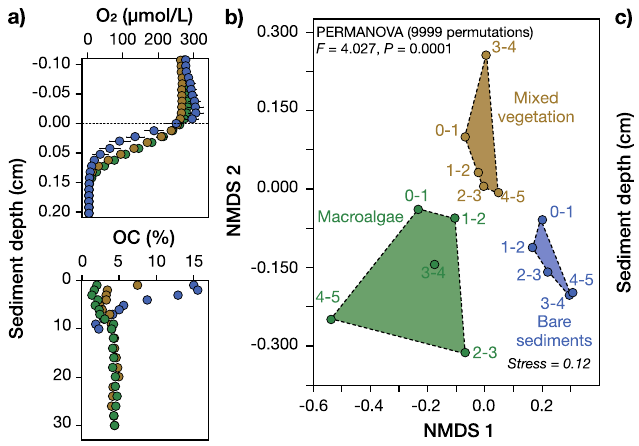
Fig. 3 | Habitat-speci fi c sediment biogeochemical and microbial character- istics. Sediment biogeochemical ( a ) and microbial ( b , c ) characteristics during the sampling in summer. ( a ) Sediment micropro fi les for O 2 and organic carbon (OC) contents. ( b ) NMDS plot of the Bray-Curtis dissimilarity index between the three habitats. The results are based on the whole 16S rRNA gene identi fi ed microbial community. The plot shows data from the fi rst 5cm layers in the sediment. The pseudo-F and P values show the statistical results from PERMANOVA (9999 permu- tations) based on testing all three habitats together. c Stacked bars showing the